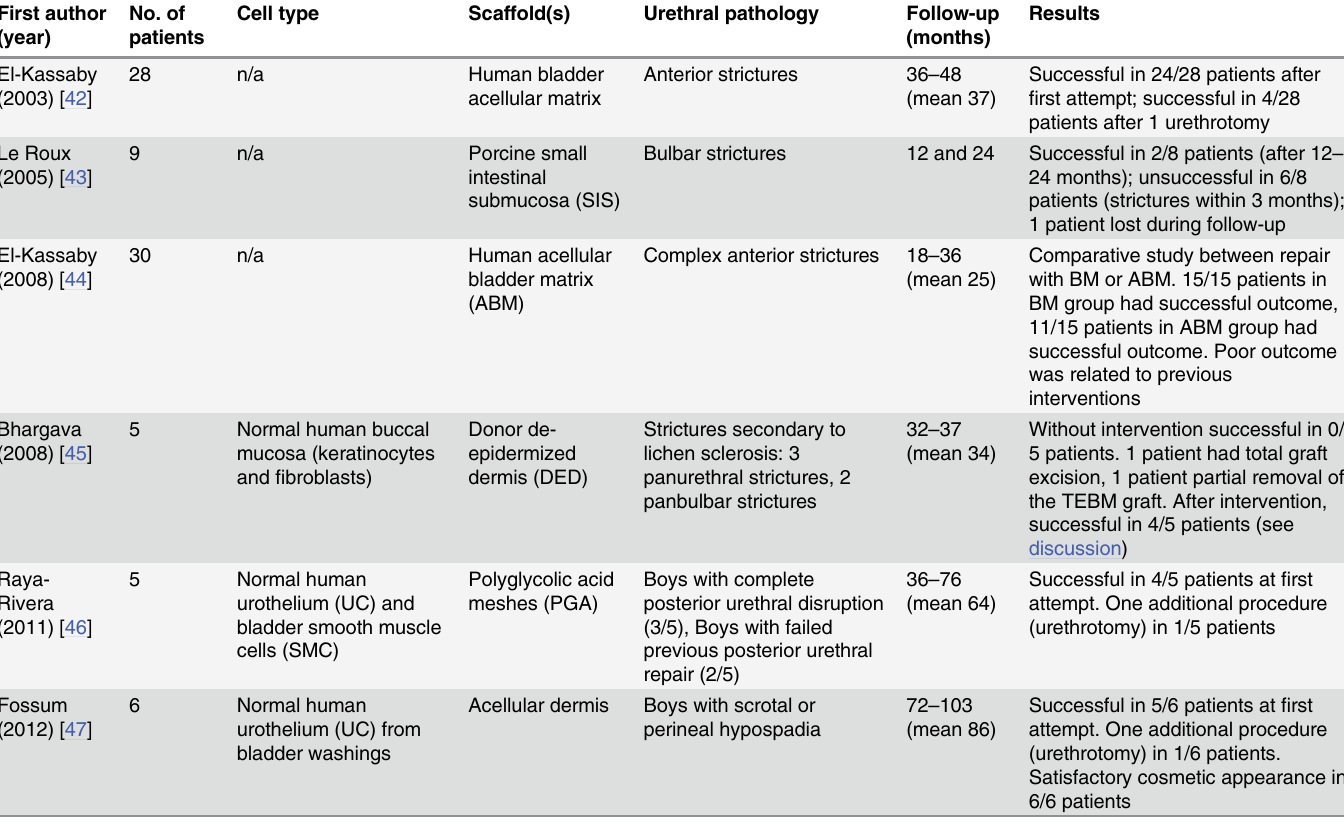
Table 3. Results of clinical studies using TE techniques (n =